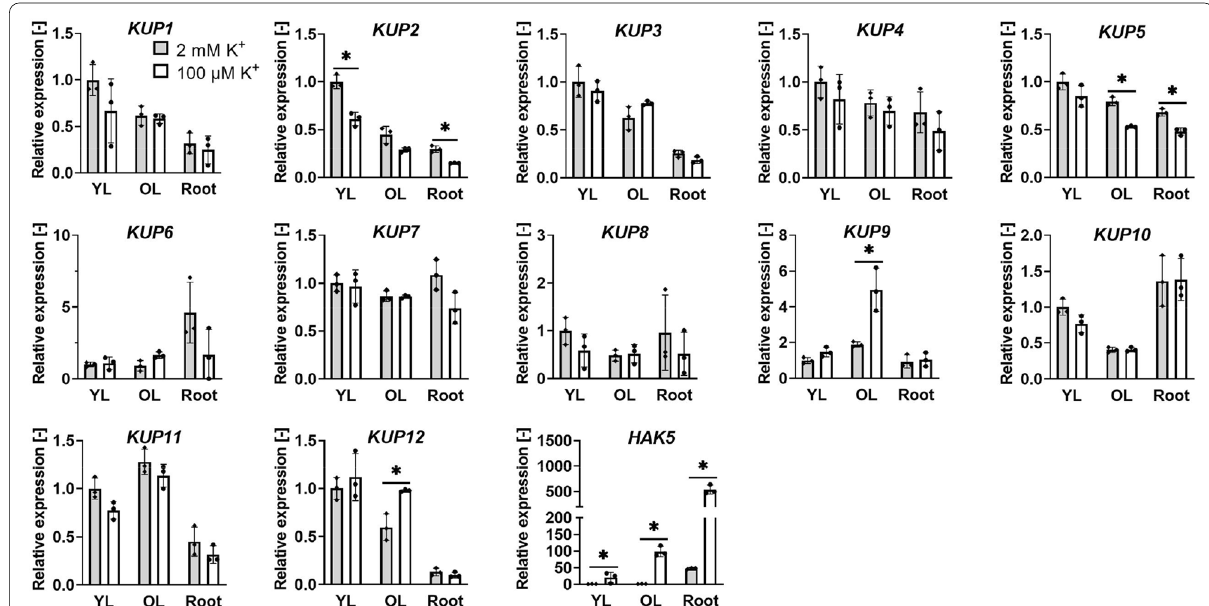
Fig. 1 Relative expression of KUP/HAK/KT transporters. Plants were grown for 2 weeks in medium containing 2 mM or 100 μM K + . Plants were at the same stage when they were dissected into the four youngest leaves (YL), the remaining older leaves (OL) and roots. RT-qPCR was performed to determine the relative levels of the KUP/HAK/KT transcripts, using ubiquitin 10 ( UBQ10 ) as the reference